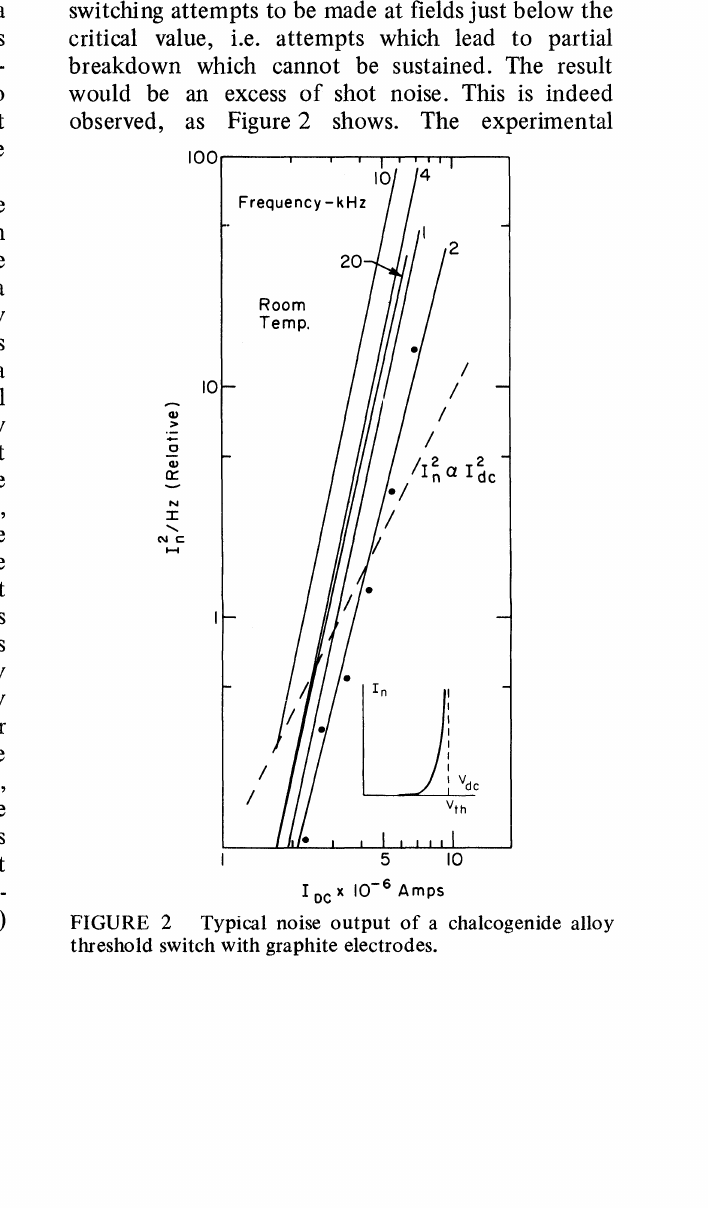
Typical noise output of a chalcogenide alloy threshold switch with graphite